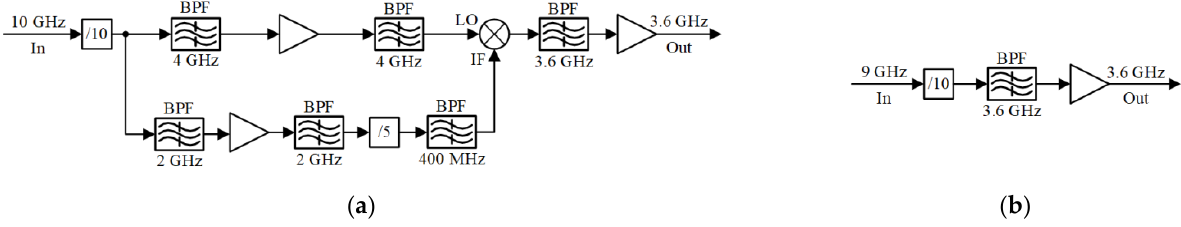
Figure 4. Simplified schematic of the frequency conversion module. ( a ) Schematic of FC1; ( b ) Schematic of FC2.